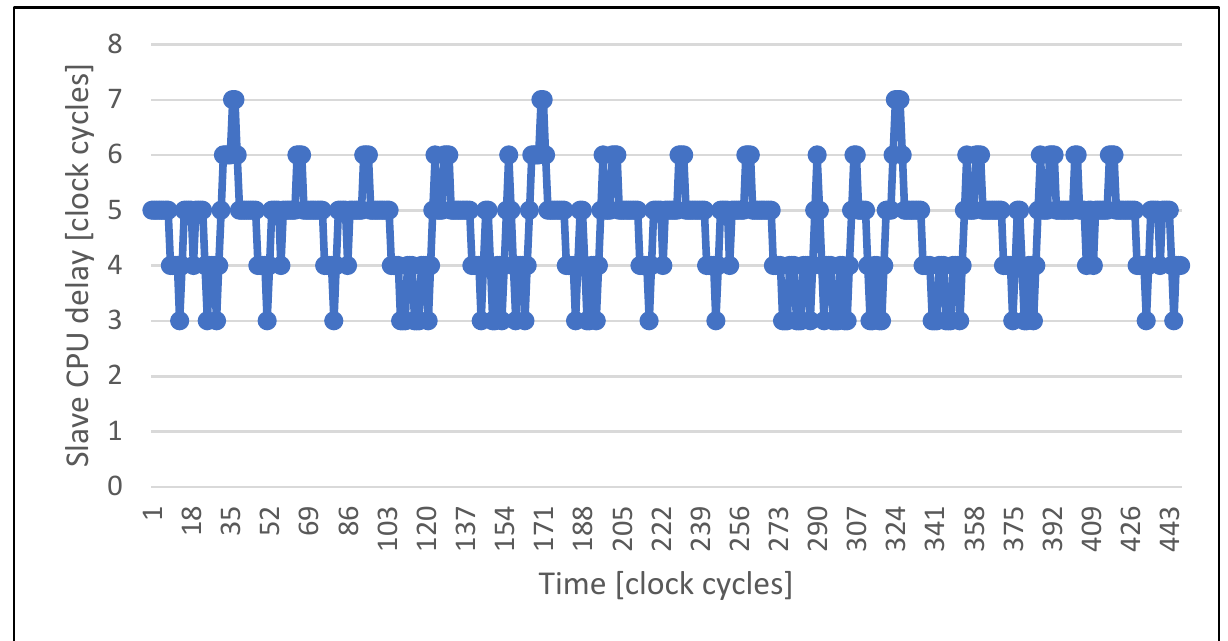
8 of 18 Figure 8. Block diagram of the VDCLS Interrupt Injection Module.